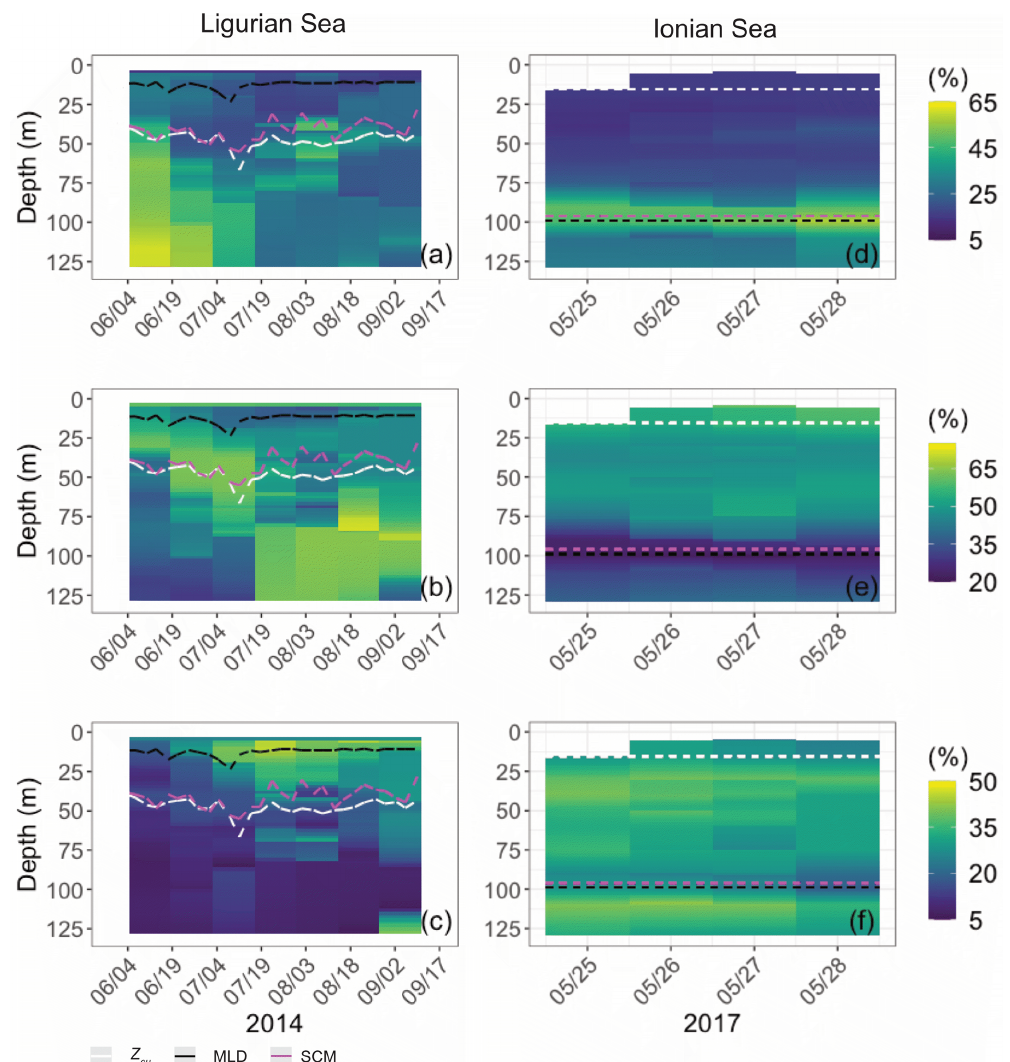
Figure 8. Depth-interpolated time series of the relative contributions (%) to the chlorophyll a concentration of the micro- (a, d) , nano- (b, e) and picophytoplankton (c, h) derived from HPLC pigment determinations in the Ligurian Sea (BOUSSOLE site; a–c ) and Ionian Sea (PEACETIME cruise; d–f ). The pigment data were collected at the BOUSSOLE site in the same region and at the same time period as the fLig float deployment (see text Sect. 2.1). The fIon float was deployed concurrently to sampling for HPLC pigments at the PEACETIME ION station. Pigment data collected at ION over 4d prior to float deployment are shown. As an indication, the euphotic depth ( Z eu ; white dashed line), the mixed-layer depth (MLD; black dashed line) and the depth of the SCM (magenta dashed line) derived from the BGC-Argo float measurements, as in Fig. 3, are overlaid onto the pigment data. Please note that the date format in this figure is